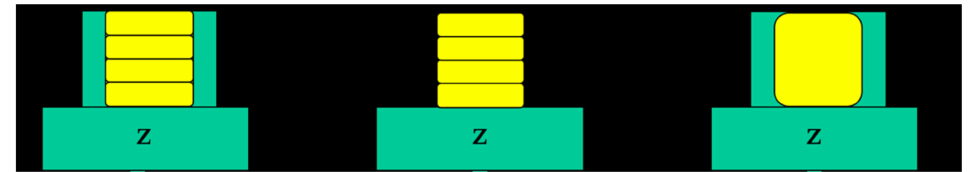
Figure 2. Illustration of the three application modes: mould filled incrementally, mould removed after incremental build up, and mould filled in bulk. z: Zirconia